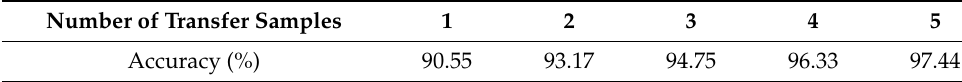
Table 9. The recognition accuracy of different numbers of transfer samples.